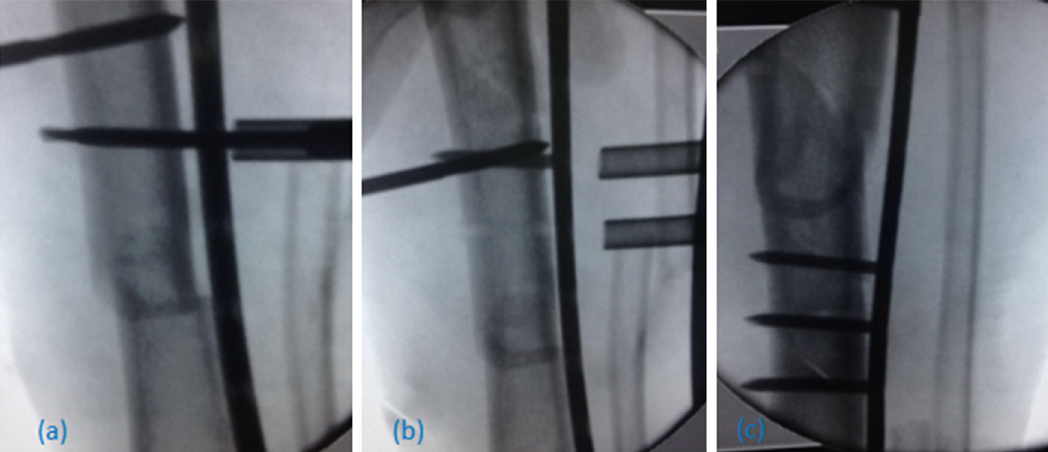
Figure 3. Intercalary segment fi xation: (a) Reduction using Schanz pin and the whirlybird. (b) First screw in place. (c) Final screws fi xation.